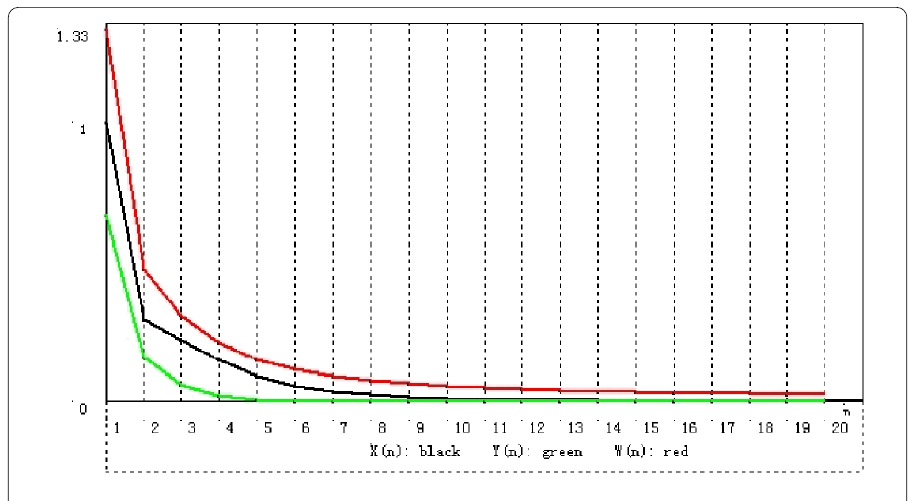
Figure 1 Convergence of { x n } , { y n } , and { w n } corresponding to Table 1